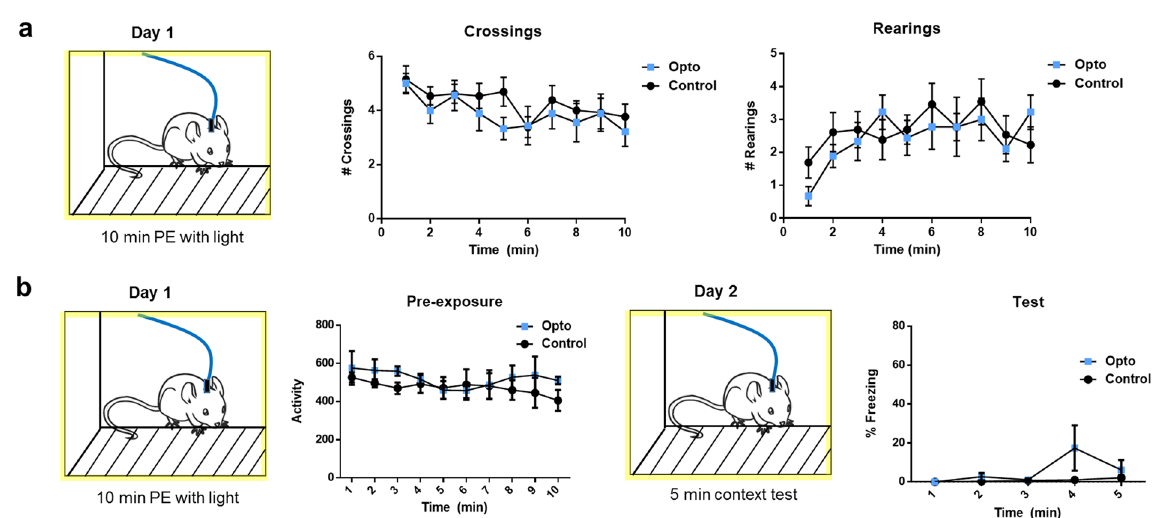
Figure 3. The behavioral protocol is shown to the left of the results from each session. ( a ) No effect of optogenetic enhancement of ACh release was observed on rearings or crossings (hand-scored) during stimulation (n = 9 opto, n = 13 control, p > 0.05). ( b ) A separate cohort was given optogenetic stimulation (n = 3 opto, n = 6 control) during pre-exposure (PE) and tested for fear behavior the following day. There was no difference in activity under stimulation (p > 0.05), and no freezing or group differences were observed at test (p >